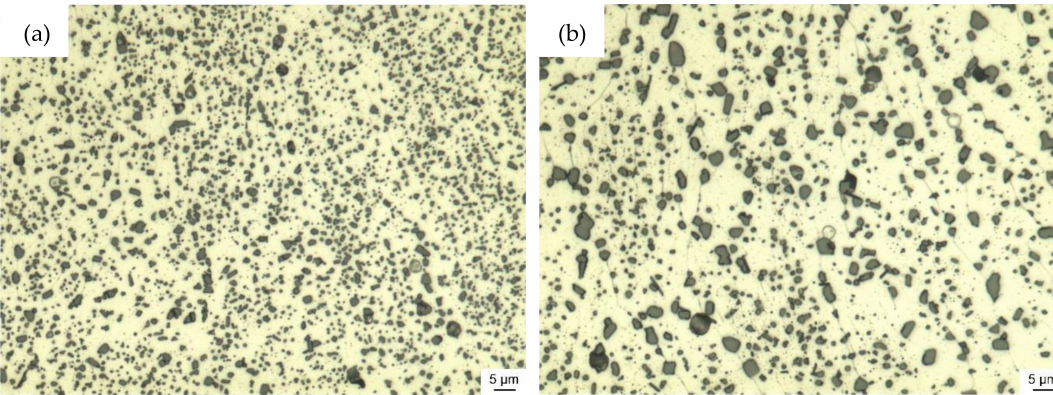
Figure 7. Micro sections of LPBF-AlSi7 samples for ( a ) 15 min and ( b ) 60 min solution annealing, followed by rapid quenching, illustrating coarsening for α -Al and Si